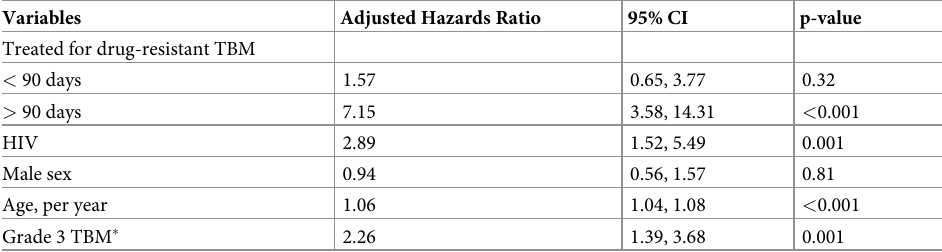
Table 3. Multivariate analysis of predictors of mortality among patients treated for tuberculosis meningitis.